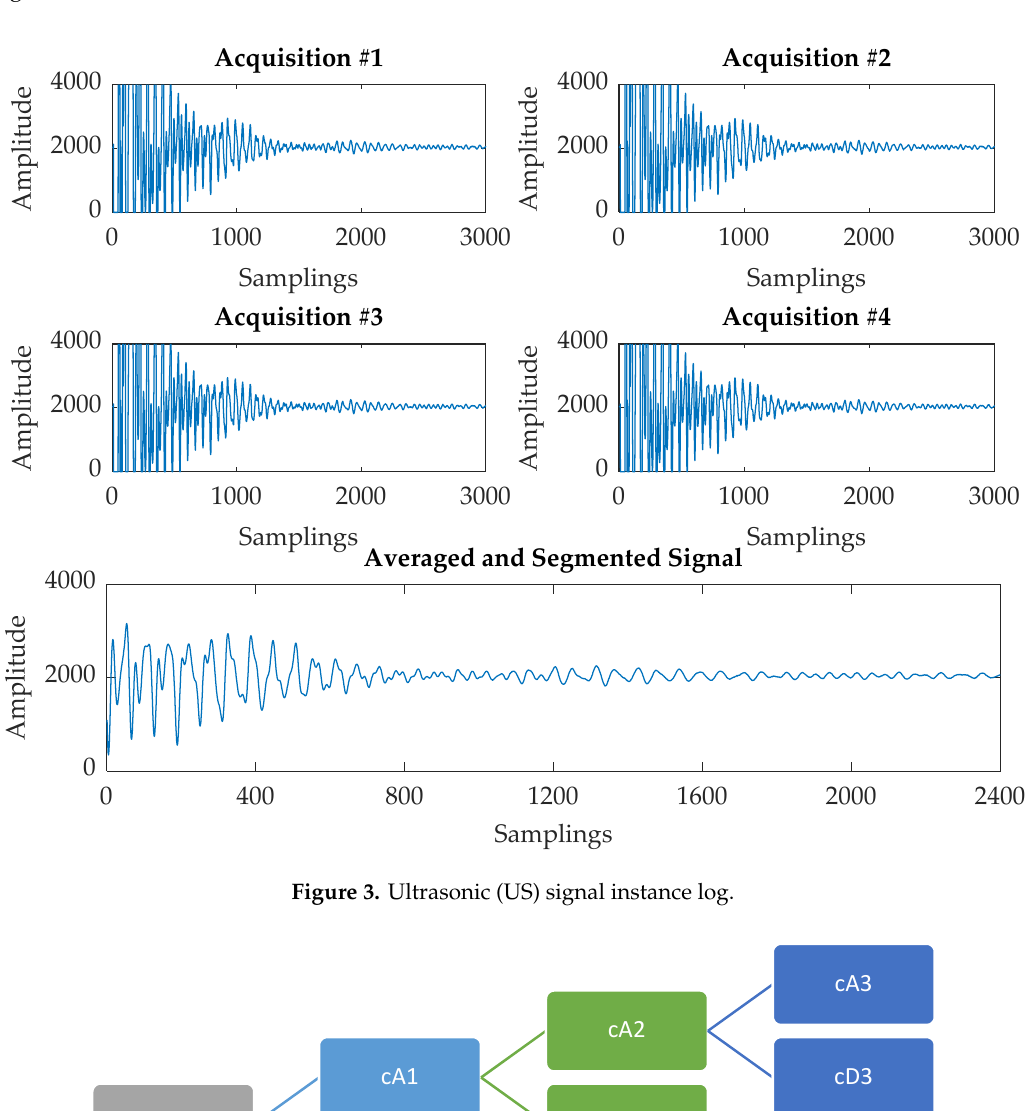
Figure 4. Wavelet decomposition tree.